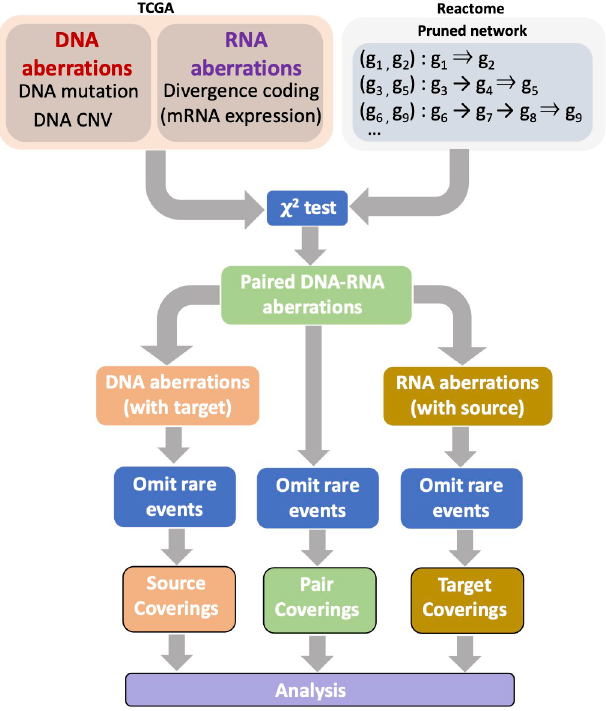
Fig 1. Overall analytical workflow. Source-target pairs (STPs) are constructed using the links available in Reactome [19]. In the TCGA cancer cohorts, the mutation and copy number variation data are used to construct binary DNA aberration profiles; the presence of either a mutation or high/low copy number variation at a given gene is treated as an aberration for the given gene for that sample omics profile. The gene expression data are used to construct binary RNA aberration profiles based on falling outside the “normal” expression range (in quantiles) for each gene based on TCGA normal tissue expression data, as previously described [14]. The binary profiles are combined to produce paired DNA-RNA aberrations, following which filtering is performed by selecting pairs that are determined to be significant (two-sided χ 2 test). The selected STPs then give rise to individual source (DNA) and target (RNA) aberrations, providing binary omics profiles at the level of source, target, and pairs. STPs that are present in less than 2% of samples for a given tissue are omitted. Then coverings are computed at the pair, source and target levels and subtype analysis and heterogeneity analysis carried